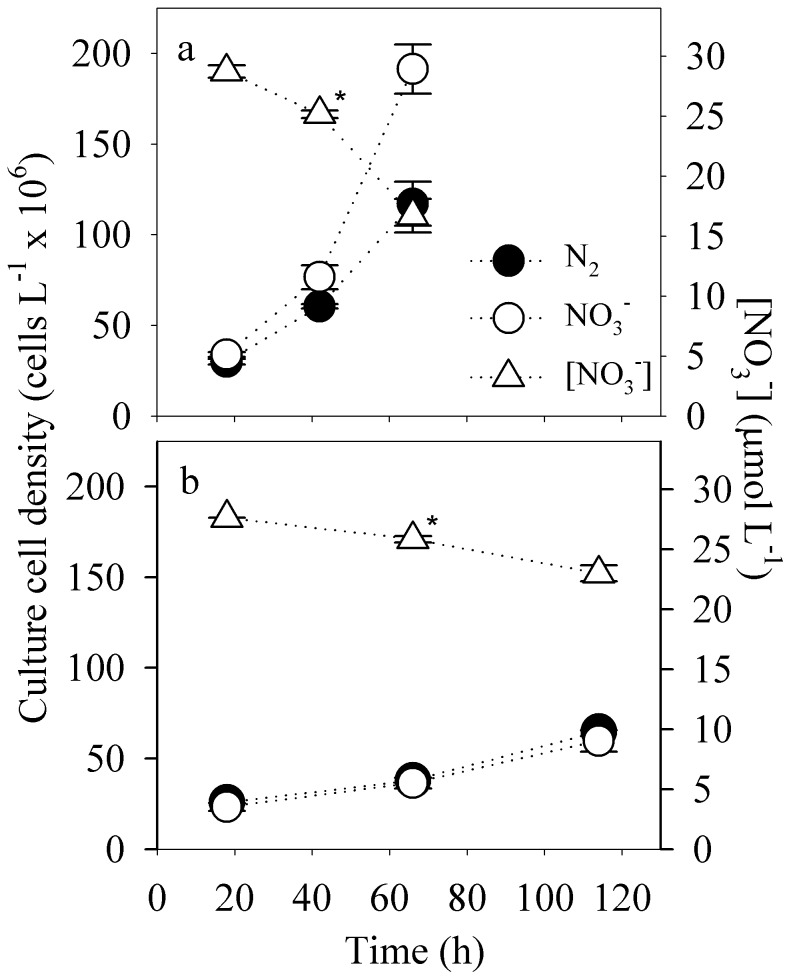
Changes in nitrate (triangles) and cell concentrations (circles) in cultures of Crocosphaera watsonii (WH0003) in long-term exposure experiments.Cultures were grown in steady state under (a) high light (175 µmol quanta m−2 s−1) and (b) low light (25 µmol quanta m−2 s−1) with added nitrate (30 µmol L−1; open symbols) or with N2 only (closed symbols). *Calculated NO3
− concentrations (see Methods section for details). Error bars represent standard deviations on means from 3 culture replicates.